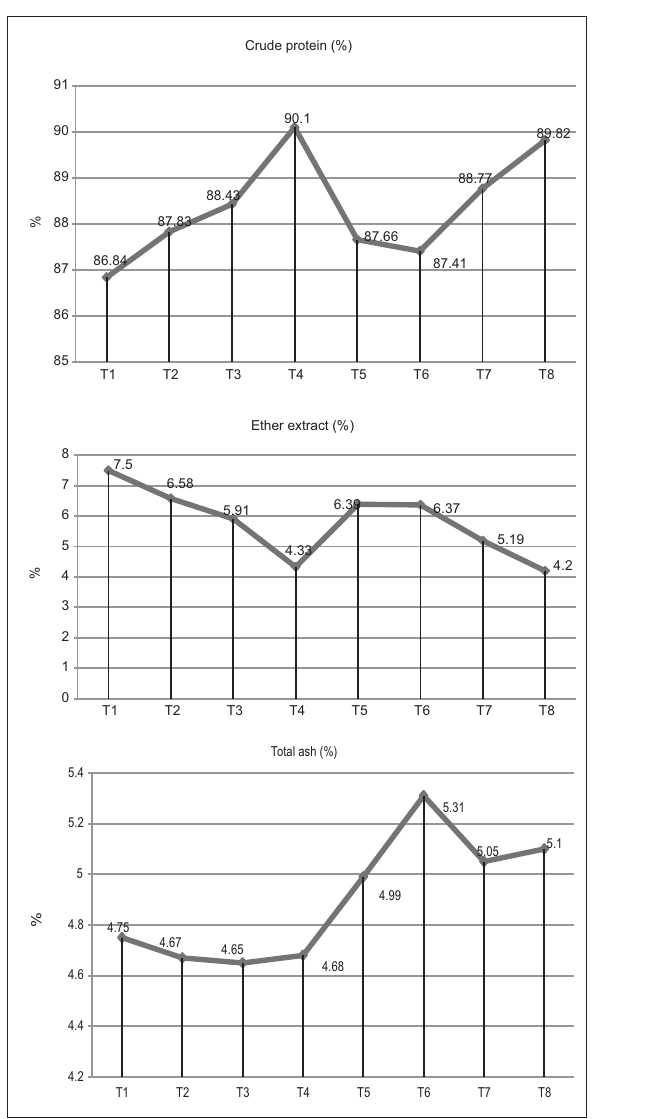
Figure-2: Trends in crude protein, ether extract and total ash content in broiler breast meat over the treatments. T : Control, T 1 W. somnifera , T